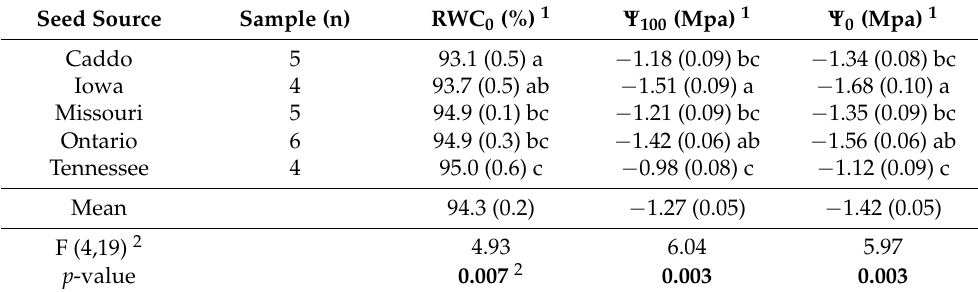
Table 6. Relative water content at zero turgor (RWC 0 ), osmotic potential at full turgor ( Ψ 100 ), and osmotic potential at zero turgor ( 0 ) (standard error of the